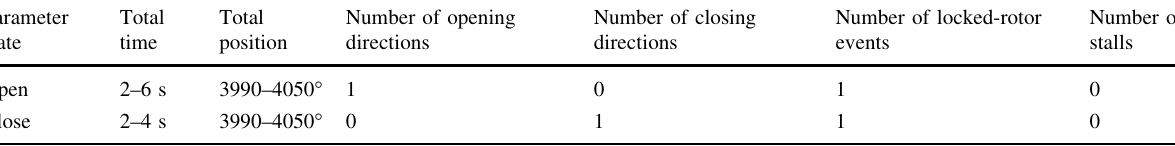
Number of opening directions